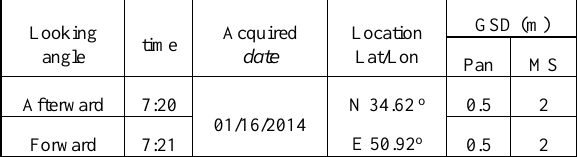
Table 1: Detail of dataset